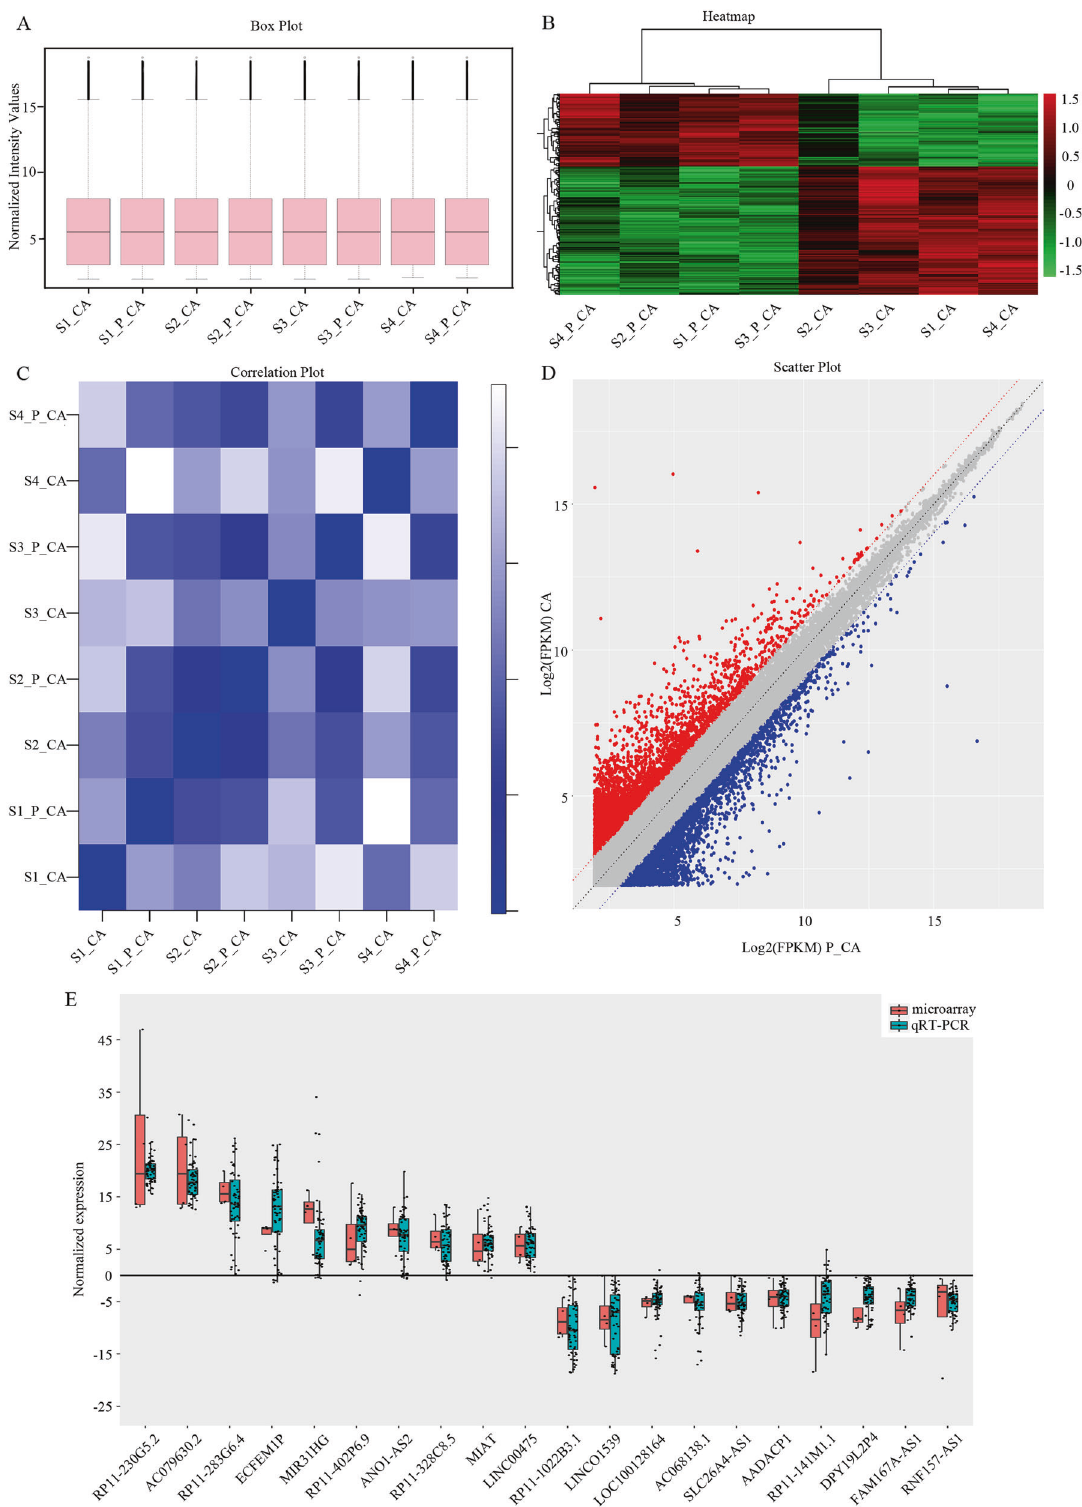
Finally, we found that 4337 lncRNAs were signi fi cantly differen- tially expressed between the PTC and noncancerous samples ( fc > 1.5, P < 0.05). Among them, 1785 lncRNAs were upregulated and 2552 were downregulated in the PTC samples compared with the noncancerous samples which were represented by scatter